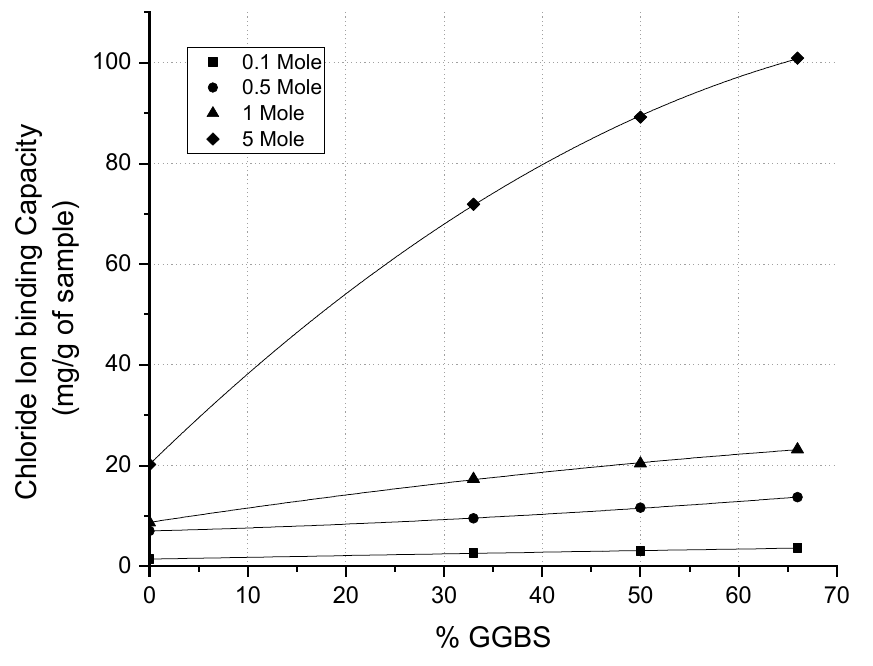
Figure 3. Effect of varying concentrations of chloride ions on chloride binding capacity [58].